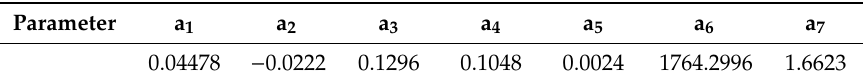
Figure 3. Experimental and predicted polymer weight loss profiles during biodegradation in water from the Bega River. from the Bega River. Table 2. Model parameter values.